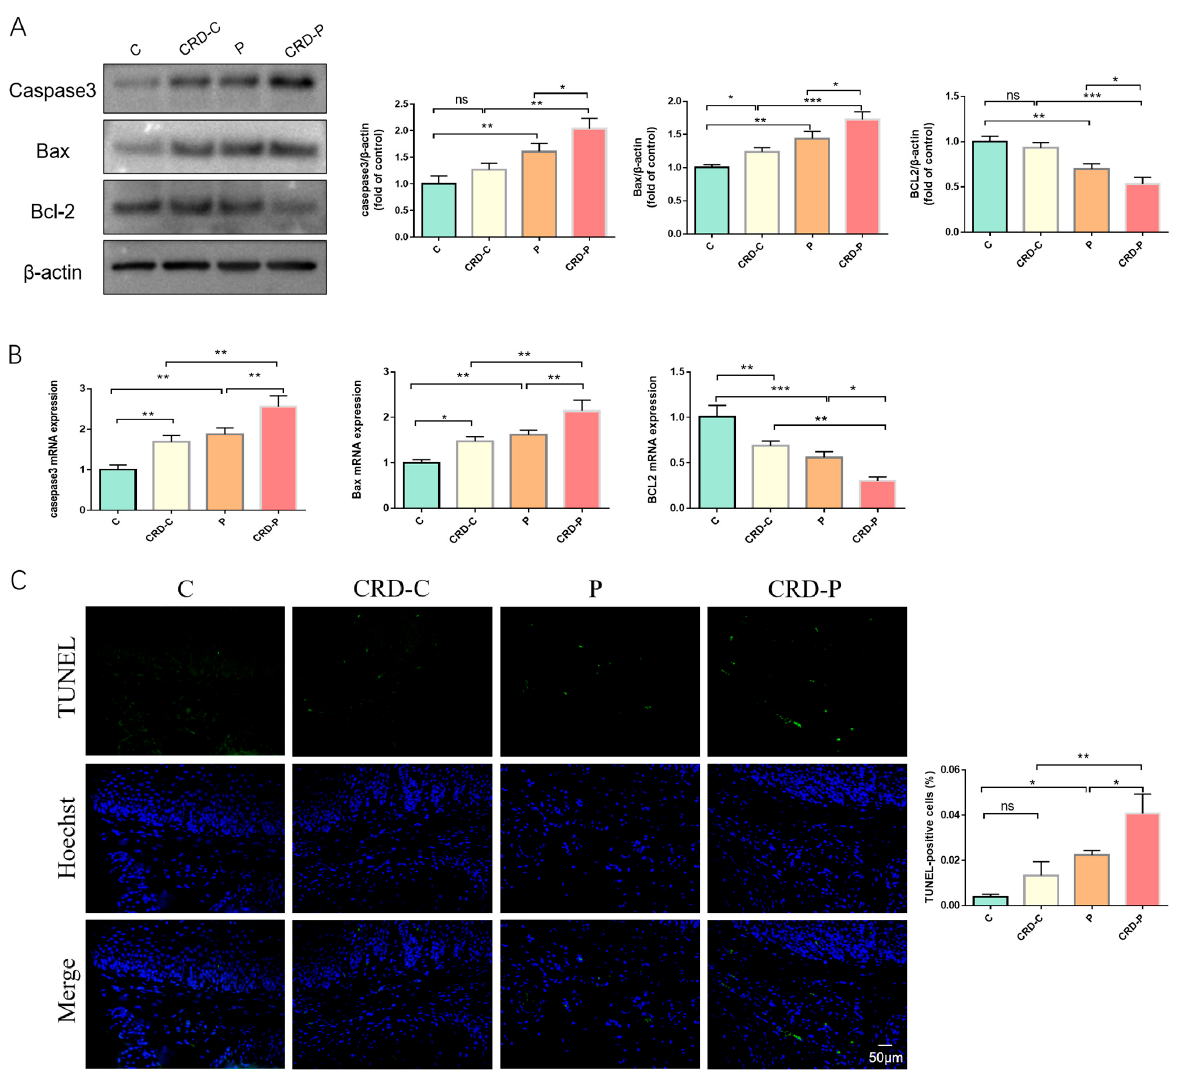
Figure 5. CRD exacerbates apoptosis in periodontal tissues. ( A ) Western blot results and analysis of Caspase3, Bax, and Bcl-2. ( B ) The apoptosis-related factor mRNA expression levels in the periodontal tissue of maxillary first molars. ( C ) TUNEL staining results. C: control. CRD-C: CRD without periodontitis. P: periodontitis group. CRD-P: CRD and periodontitis. Data are presented as the mean ± SD. ns, not significant difference; * p < 0.05; ** p < 0.01; *** p < 0.001.